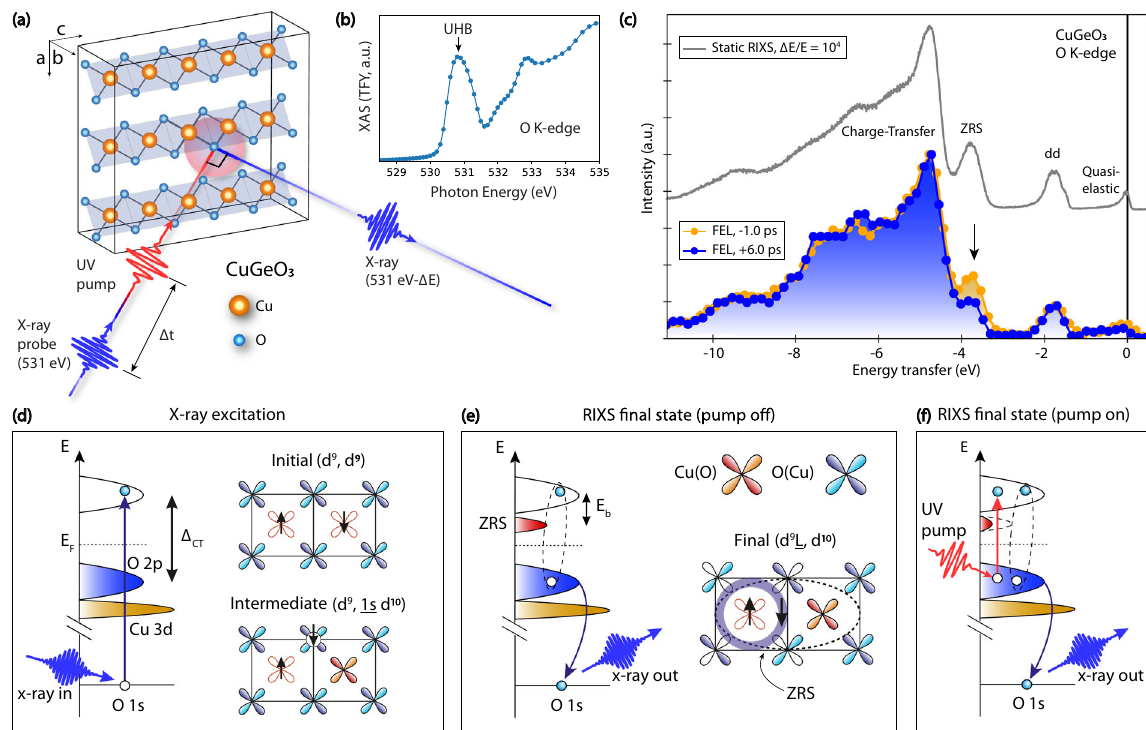
Fig. 1 Experimental overview and schematic of ZRS formation. a Sketch of the experimental scheme at the SXR beamline of the LCLS X-ray free-electron laser (FEL) facility. The laser pump pulse (4.7 eV, 50 fs) is followed by a collinear X-ray probe pulse (531 eV, 70 fs). The radiation re- emitted by the sample is then analyzed using a grating-based spectrometer. b Static O K -edge XAS spectrum of CuGeO 3 , taken at 20 K using a synchrotron light source. The data are acquired in the same experimental geometry as the FEL experiment. c A comparison between the O K - edge RIXS spectrum obtained at a synchrotron radiation facility with a resolving power 10 4 (shown with a vertical offset) and those obtained with FEL radiation for a negative delay (yellow markers) and a positive delay (blue markers). Fluence = 37.4 mJ cm − 2 . The black arrow marks the position of the Zhang – Rice singlet (ZRS) excitation. d – f Schematics of the ZRS formation in the O K -edge RIXS process described in the main text. In the schematics, E F is the Fermi level, Δ CT is the charge-transfer energy, and E b is the ZRS binding